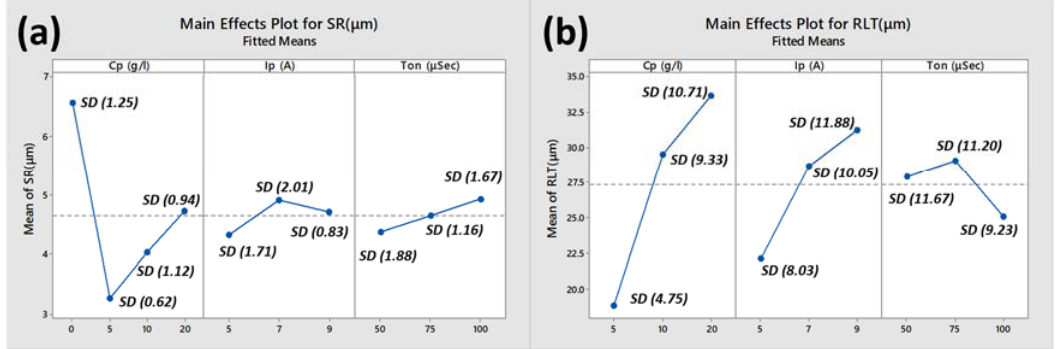
Figure 9. Main effect plots ( a ) surface roughness ( b ) recast layer thickness. Figure 9. Main e ff ect plots ( a ) surface roughness ( b ) recast layer